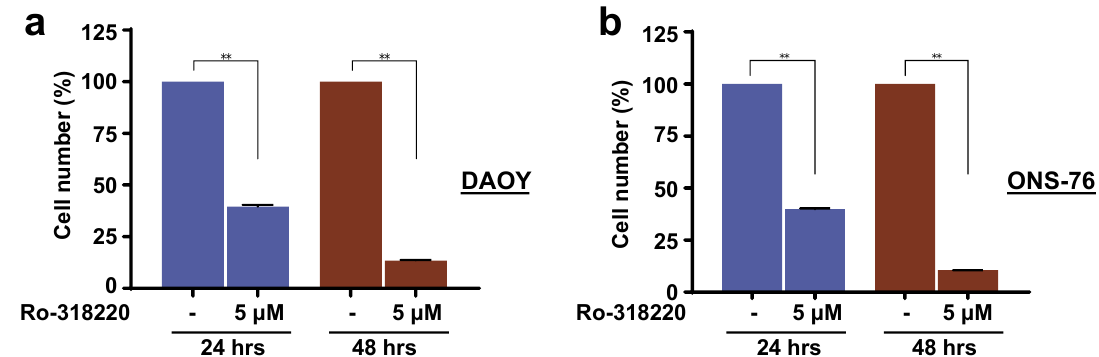
Figure 6. MAPK15 pharmacological inhibition reduces medulloblastoma cell proliferation. DAOY ( a ) and ONS-76 ( b ) cells (3 × 10 4 ) were seeded in 12-well plates and, after 24 h, treated with the Ro-318220 MAPK15 inhibitor (5 µ M), for the indicated times. Cells were next harvested and counted. **, p < 0.01.